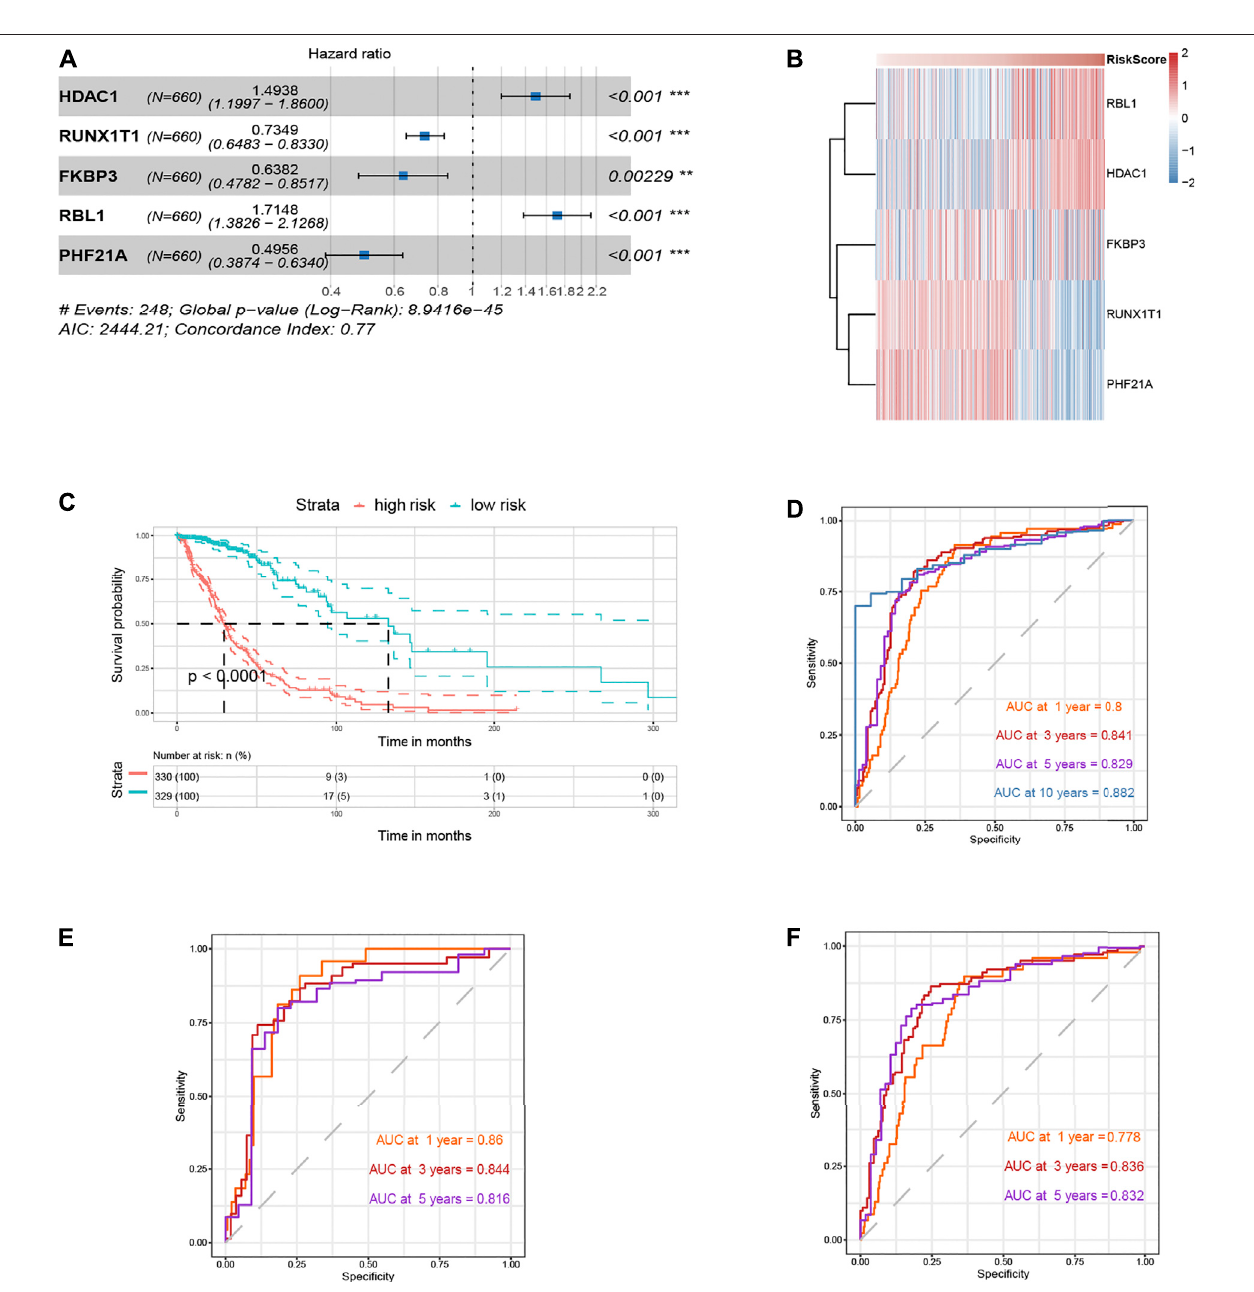
FIGURE10| HDAC1 -relatedgenesignatureconstructionandinternalvalidation. (A) Forestplotforthe HDAC1 -relatedgenesignature. (B) Heatmapforexpression pro fi les of the signature components in the TCGA glioma cohort. (C) Survival curve for survival possibility test between high- and low-risk group according to the signature risk score in the TCGA cohort. (D) Time-dependent ROC curve for the separability test of the HDAC1 -related signature at 1-, 3-, 5-, and 10-years time points (OS) using the TCGA developing cohort. (E) Time-dependent ROC curve for the HDAC1 -related signature using the TCGA training set. (F) Time-dependent ROC curve for the HDAC1 -related signature using the TCGA testing